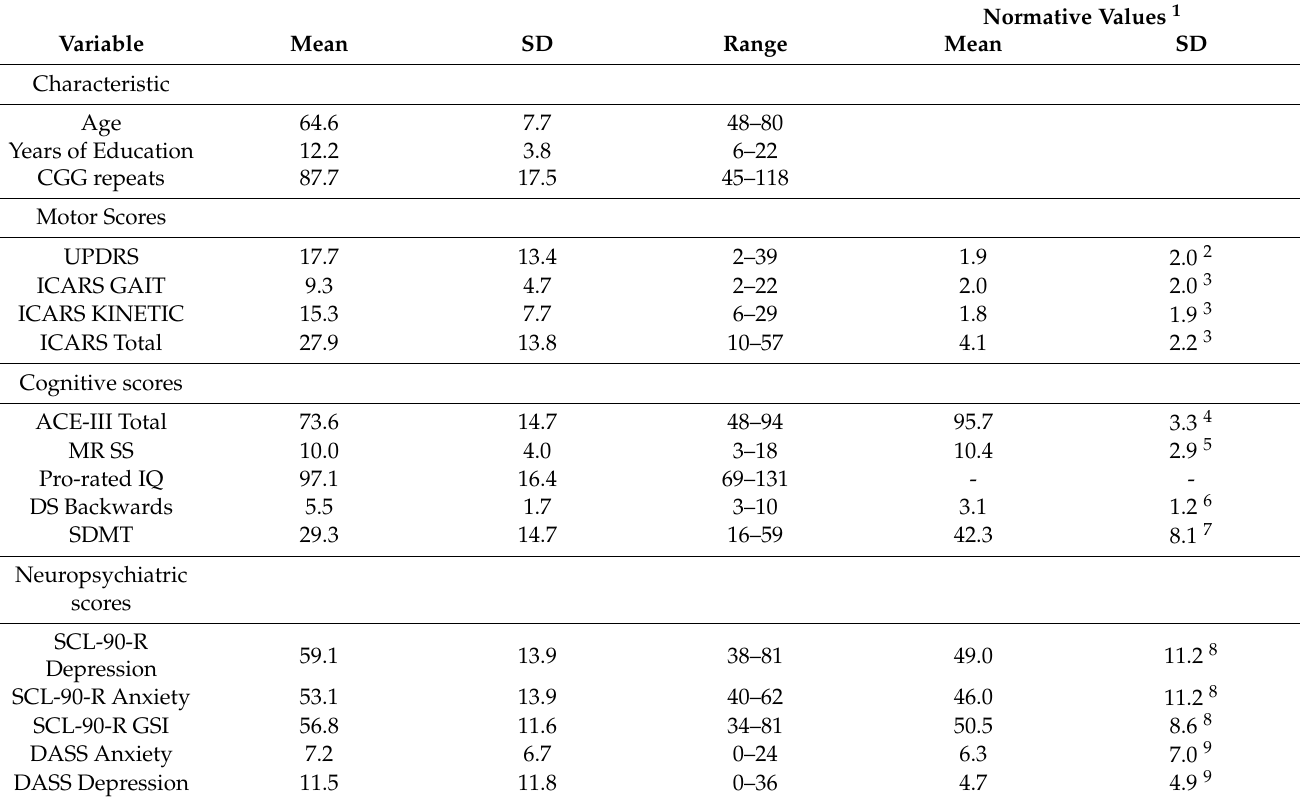
Table 1. Demographic, motor, and cognitive psychiatric